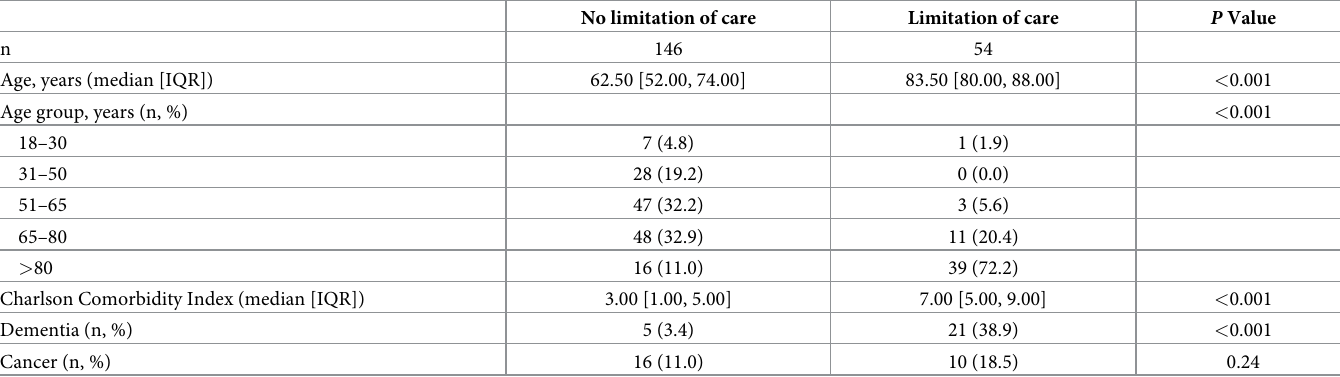
Table 1. Comparison of patients with and without limitation of care.